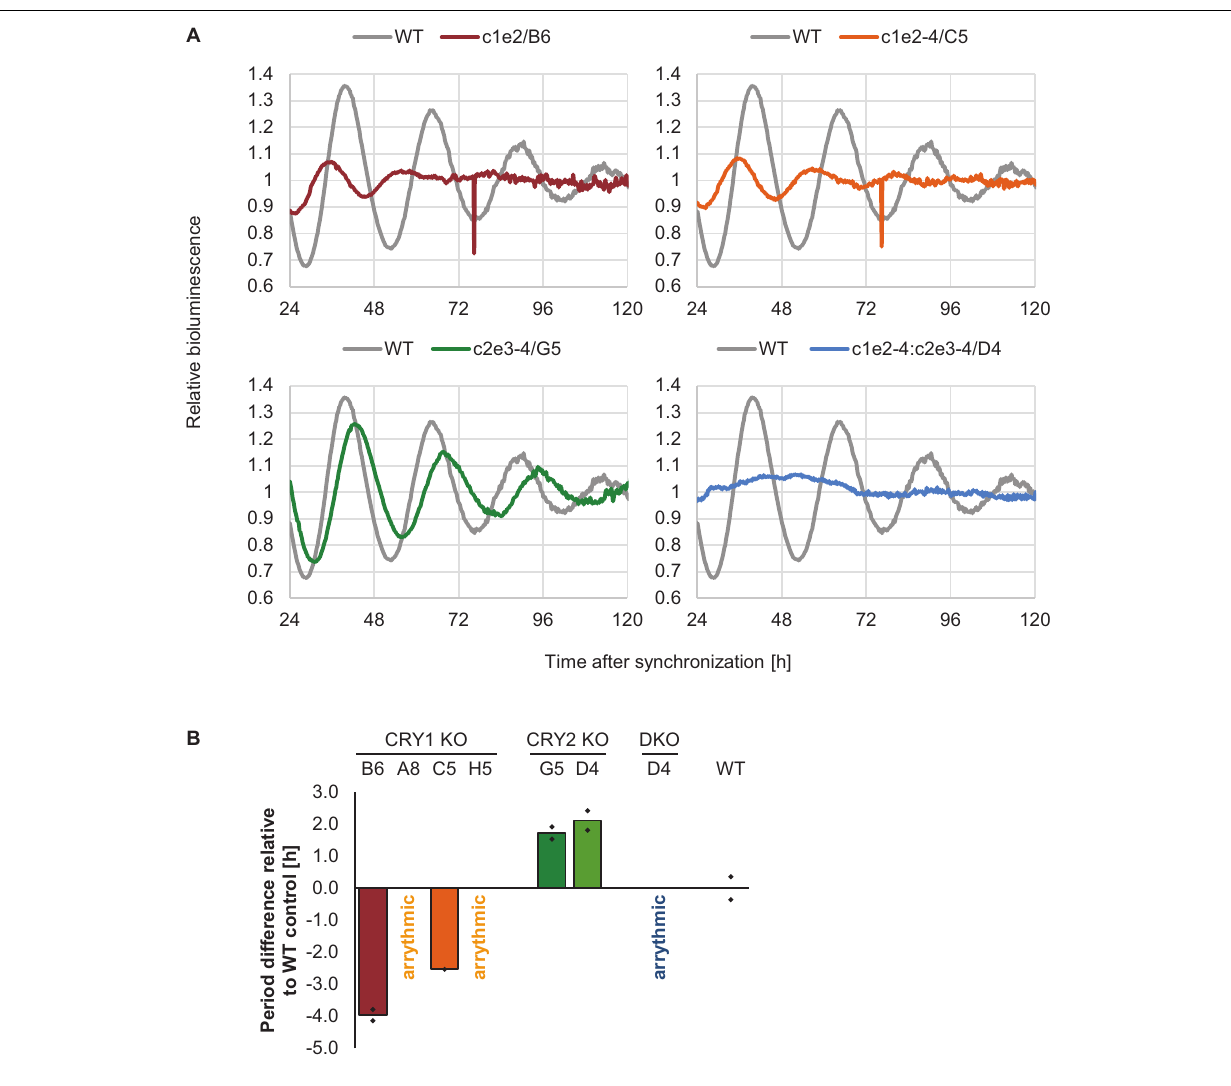
(Haeussler et al., 2016 1 ) and ligated into the lentiCRISPR v2 plasmid (Addgene #52961) (Sanjana et al., 2014) using a BsmBI restriction